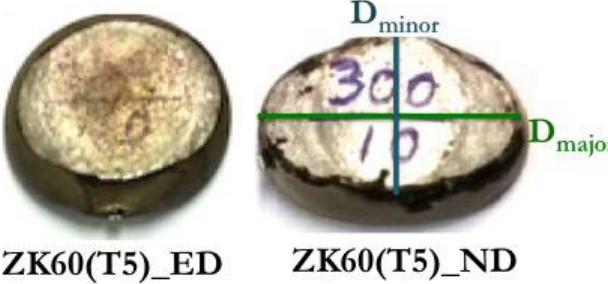
Figure 5. Typical shapes of the specimens (top view) compressed along ED and ND. The loading direction is normal to the plane of the paper. Metals 2019 , x, x; FOR PEER REVIEW